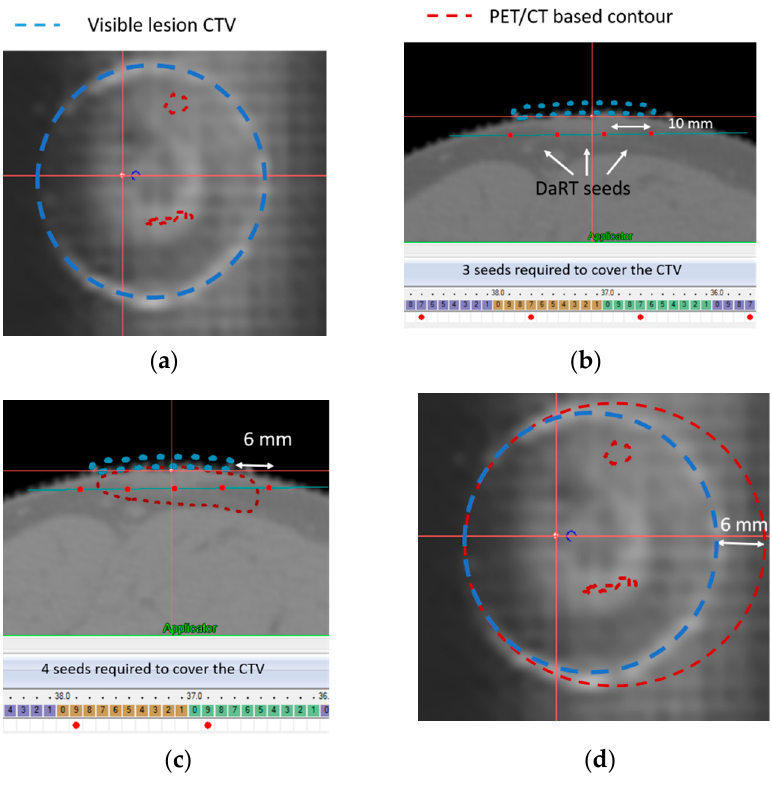
Figure 8. ( a ) Visible CTV drawn with the radio-opaque marker by the physician highlighted in blue over the radio-opaque trace. ( b ) Geometrical planning on CT with the TPS with the 1 cm long DaRT seeds represented by red dots. The coverage of blue CTV is achieved with three seeds. ( c ) The PET/CT-based CTV is depicted in red alongside the blue CTV, indicating subcutaneous tumour invasion and the necessity for four DaRT seeds for proper lesion coverage. ( d ) Final estimation of the CTV is drawn on the template mesh in order to update the physical template.